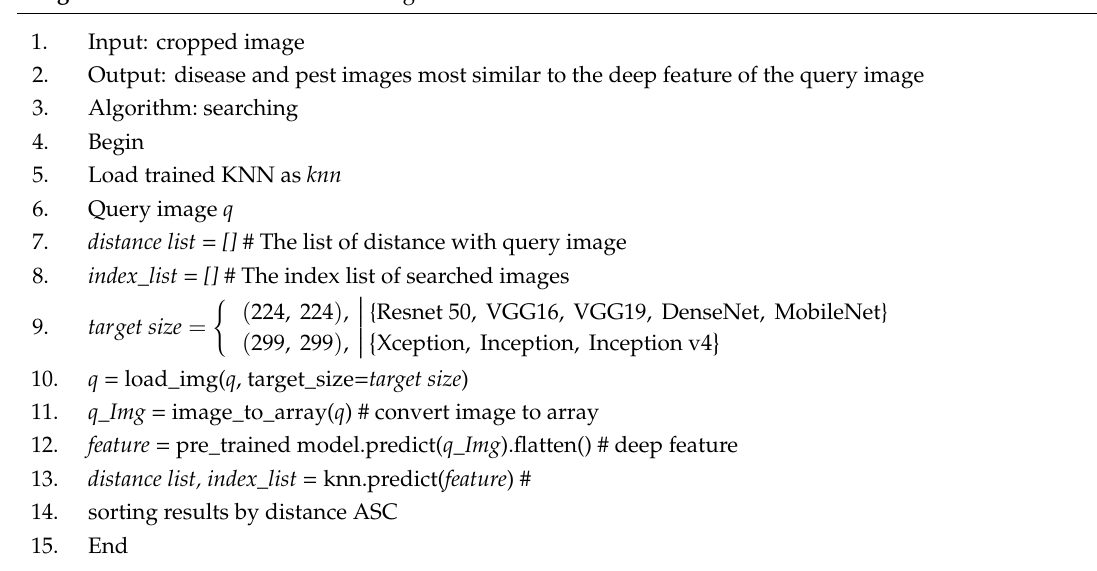
Algorithm 2. Pseudocode of searching.